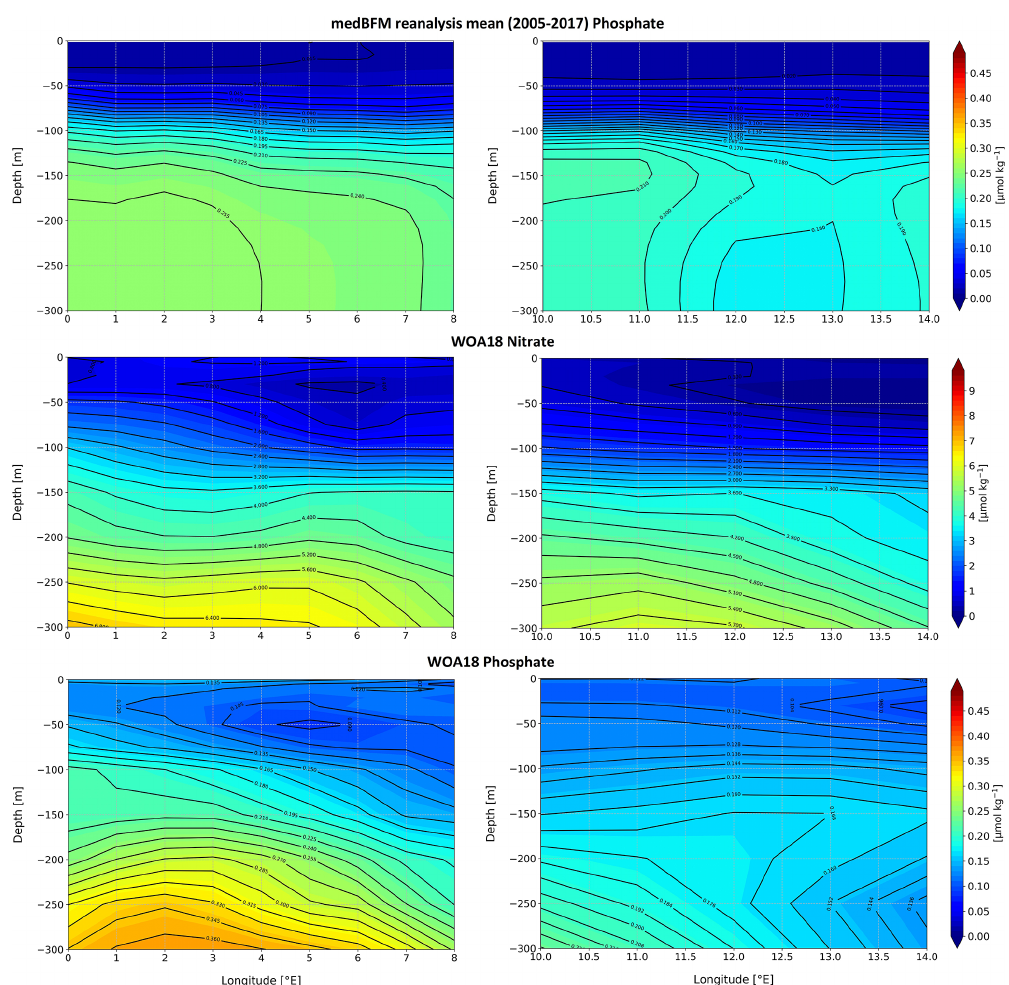
Figure 16. Vertical distribution of nitrate and phosphate from the Algerian Basin and Tyrrhenian Sea. Colors show the gridded values from the three different products: BGC-WMED, MedBFM reanalysis (Teruzzi et al., 2019) and the WOA18 (Garcia et al.,